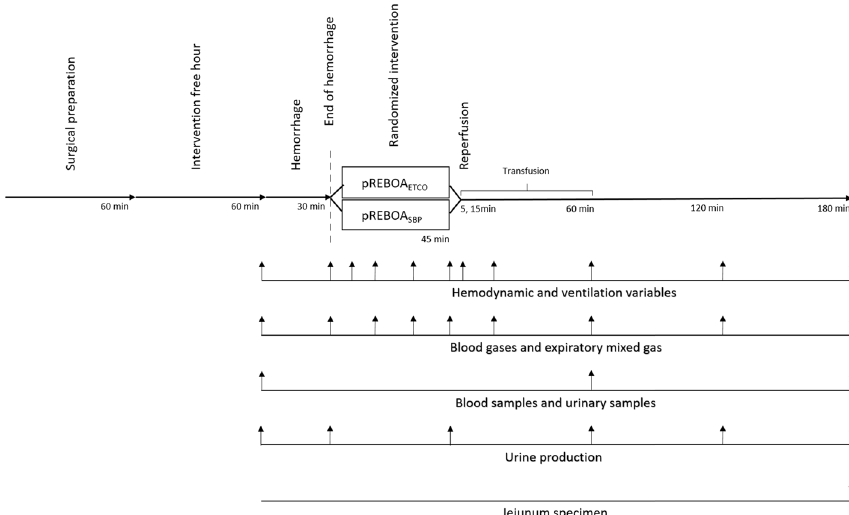
Fig. 1 Experimental protocol of partial endovascular balloon occlusion of the aorta (pREBOA) targeted by end-tidal carbon dioxide (pREBOA ETCO2 , n 10) and proximal systolic blood pressure (pREBOA SBP , n = anesthetized, mechanically ventilated pigs. Each arrowhead indicates a measurement